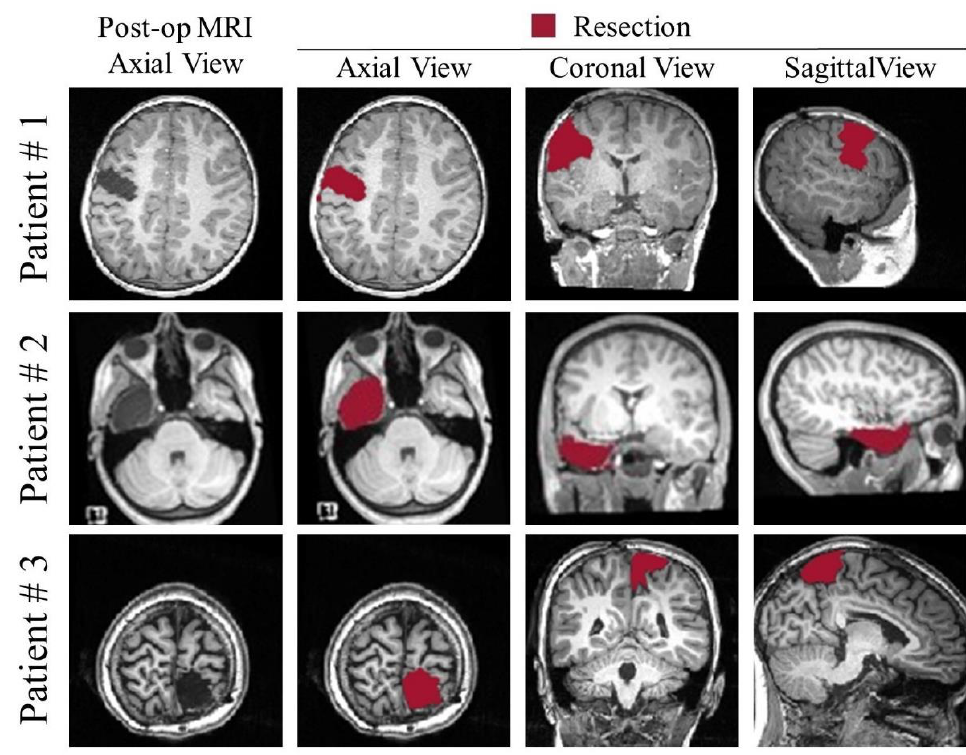
Figure 9. Examples of segmentation from the presented GUI from three different patients: left frontal resection (#1), left temporal resection (#2); right parietal resection (#3).